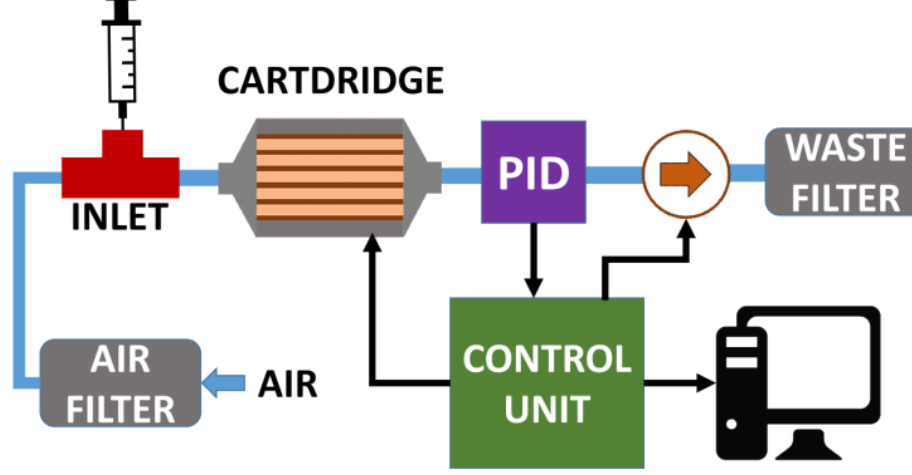
Figure 1. Scheme of the developed